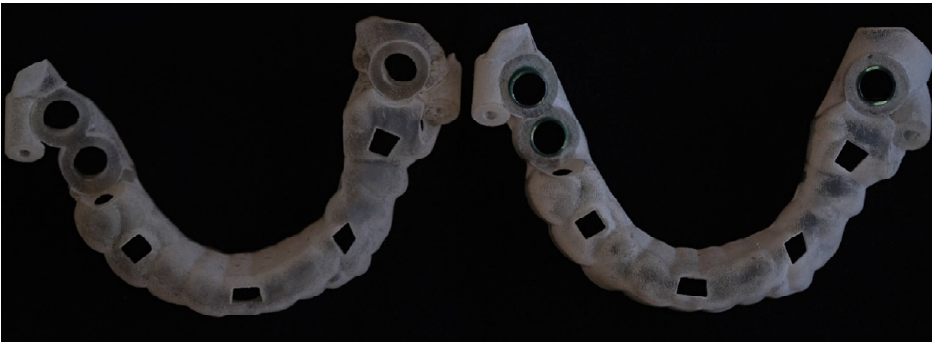
Figure 6. Two types of surgical guides adjusted to different types of surgical tools.